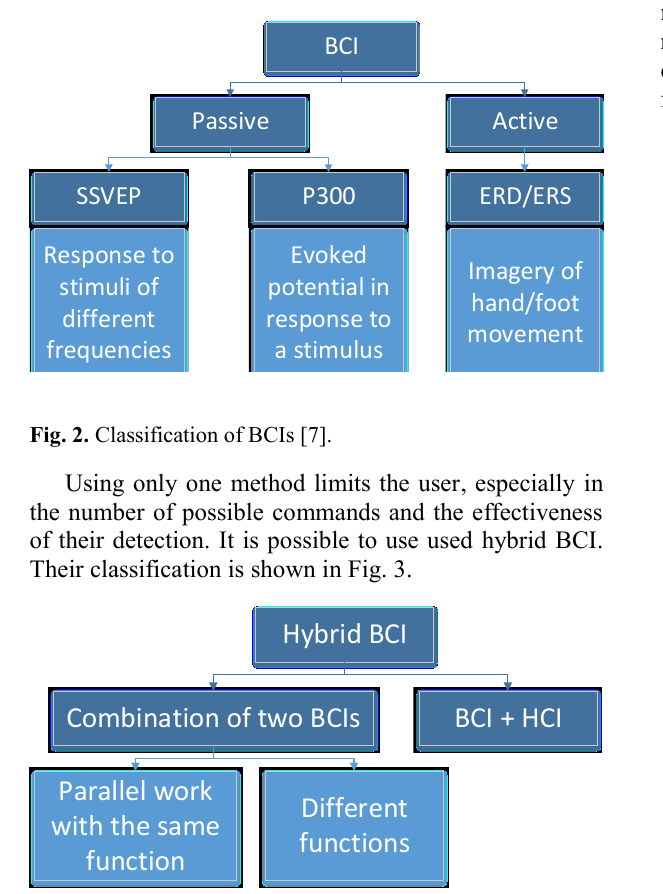
Fig. 4. Electrode Oz output signal FFT characteristics for: no blinking (a), LED blinking with 15 Hz